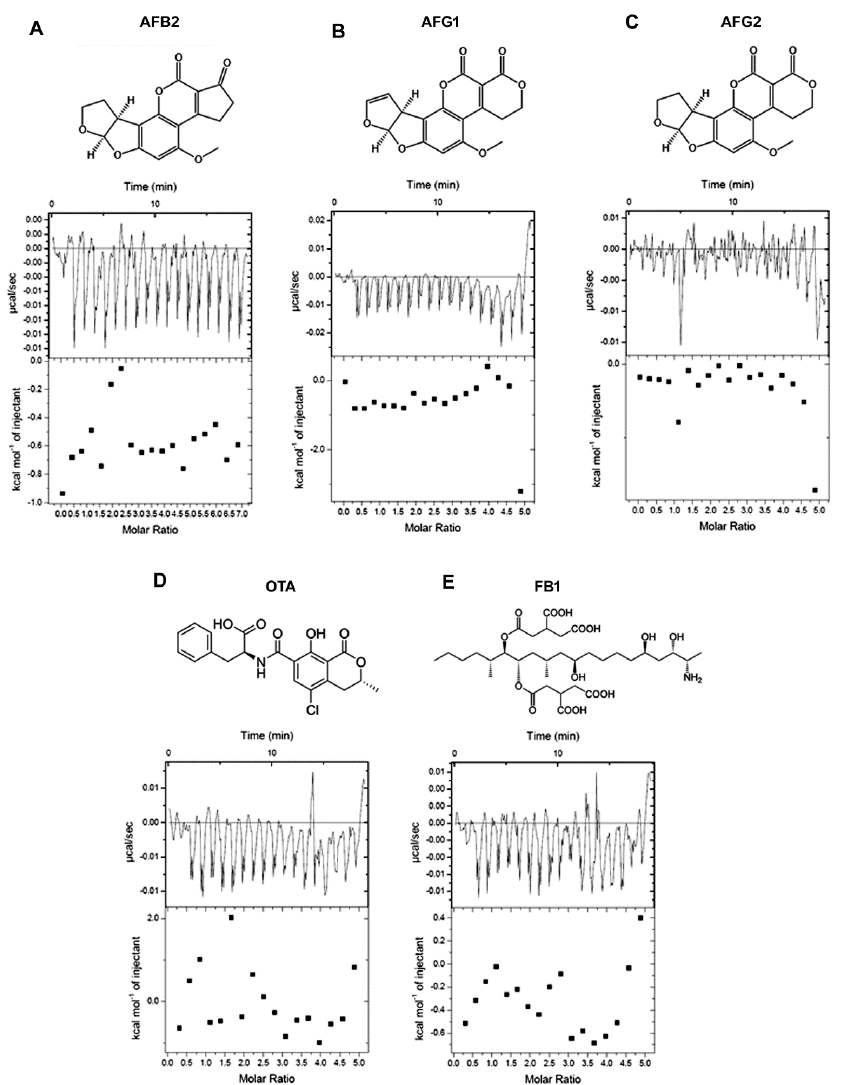
Figure 3. Binding affinity of aptamer fl − 2CS1 with ( A ) AFB2, ( B ) AFG1, ( C ) AFG2, ( D ) ochratoxin (OTA), and ( E ) fumonisin B1 (FB1) determined by ITC.